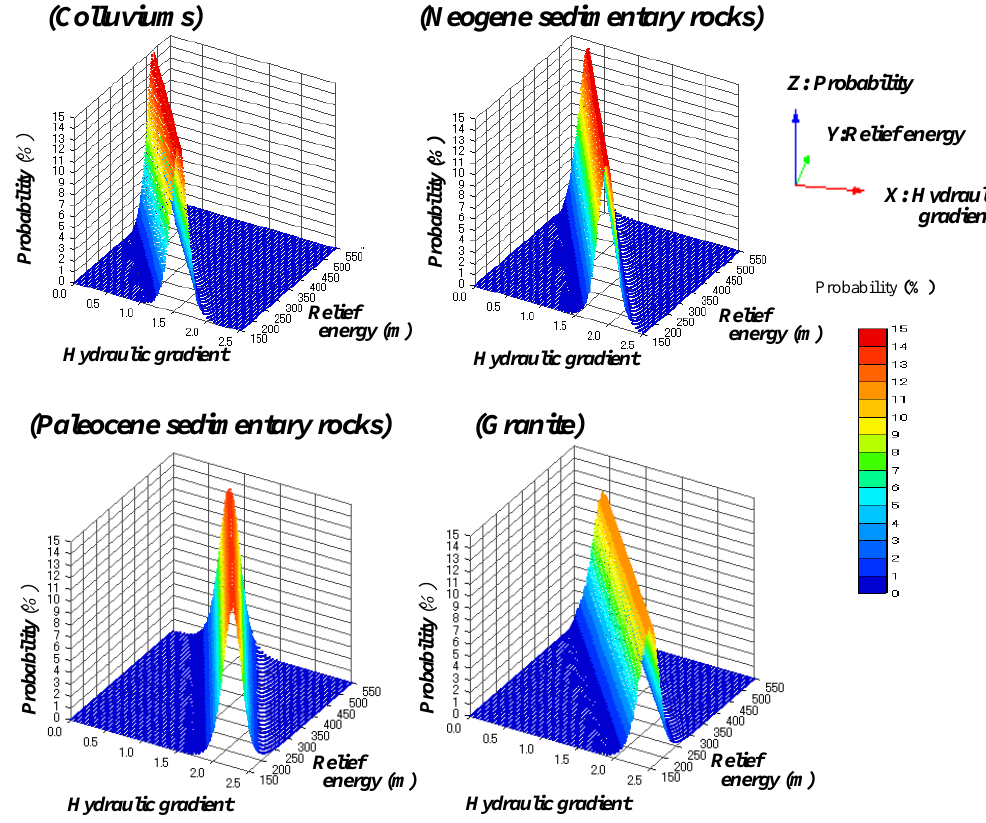
Fig. 9. Relationship between the change in landslide hazard probability and change in hydraulic gradient and relief energy for the four geological parameters